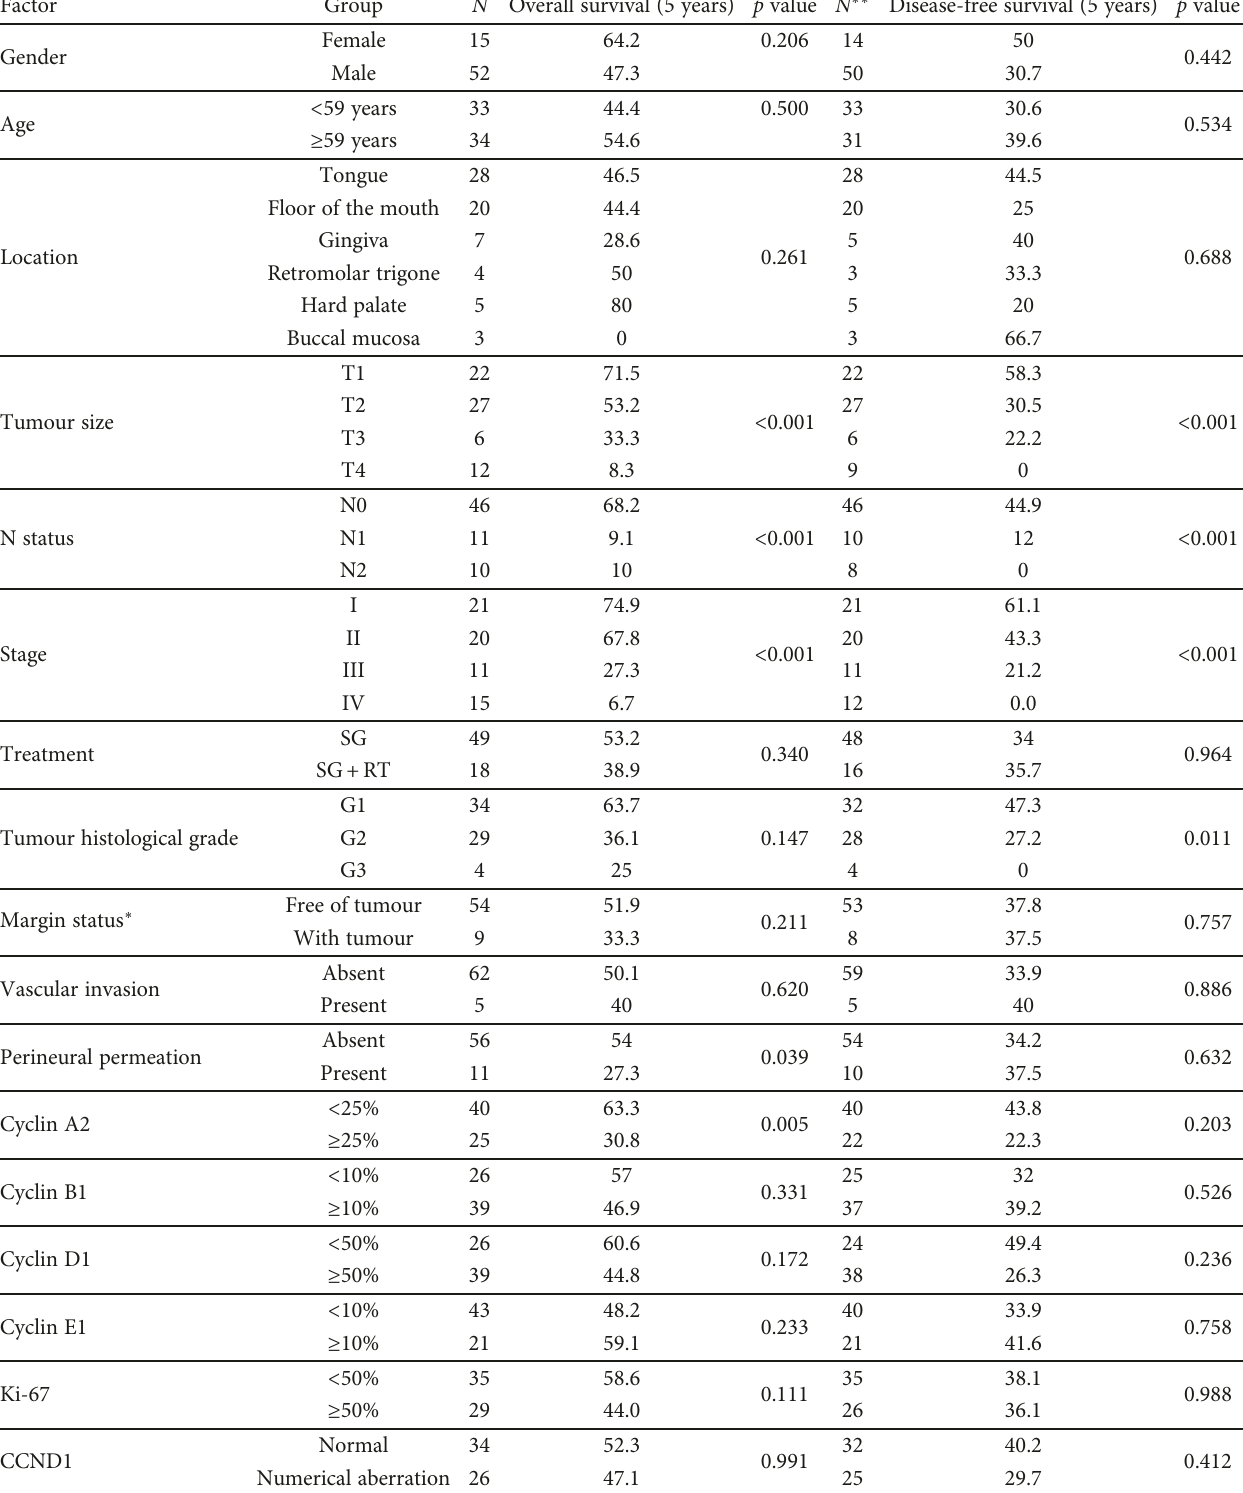
Table 3: Univariate analysis of overall survival and disease-free survival at 5 years, according to clinicopathological characteristics and marker